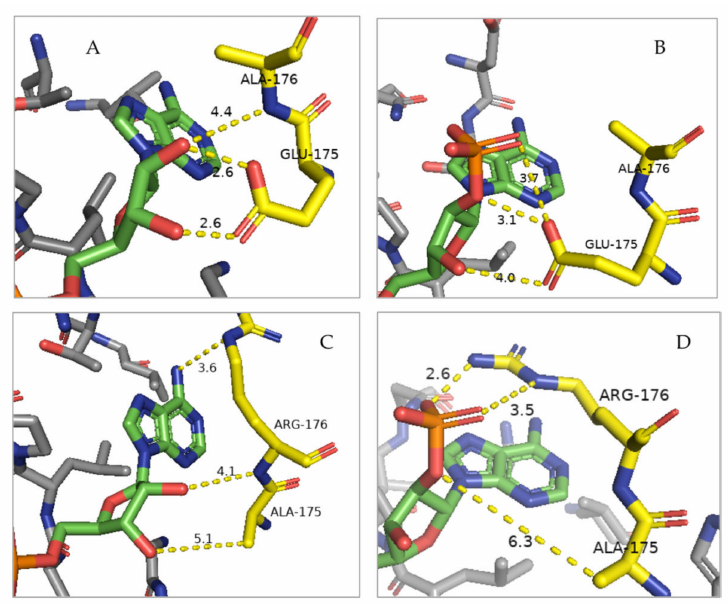
Figure 7. Molecular model of the cofactor-binding pocket in the PTXD enzyme showing the e ff ects of the double amino acid substitution (E175A, A176R) on the docking of the NAD + vs NADP + cofactors. The interactions between the nucleotide moiety of both cofactors (in green) with residues 175 and 176 (in yellow) are shown. Charge interactions are depicted as yellow dashed lines with distances in Angstrom between the hydrogen bond acceptor atoms to hydrogen atoms. ( A ) NAD + cofactor binding by the wild type enzyme, where multiple polar interactions are allowed between the 2 (cid:48) - and 3 (cid:48) -hydroxyl groups (in red) of the nucleotide and the side chain of glutamate-175 and the peptidyl nitrogen